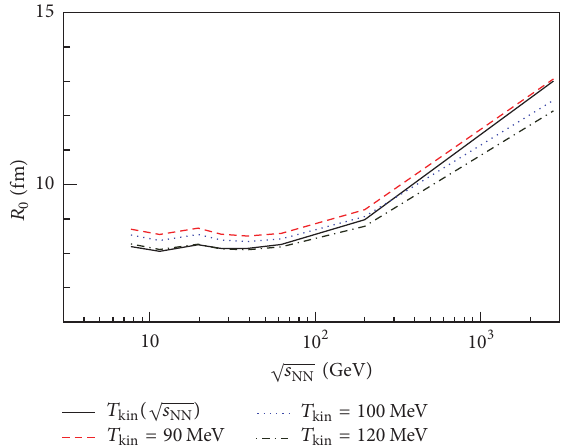
Figure 5: 𝑅 0 as a function of centre-of-mass energy √𝑠